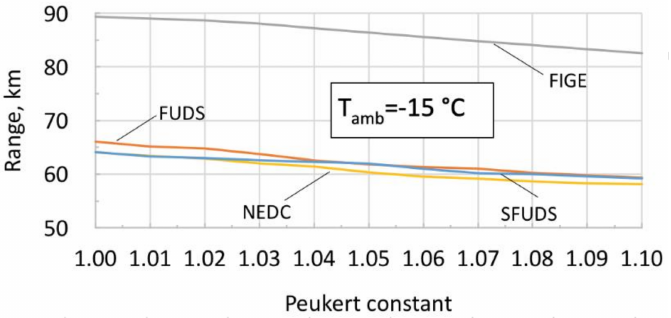
Figure 6. Driven range as function of the Peukert constant k in the case of ambient temperature of − 15 ◦